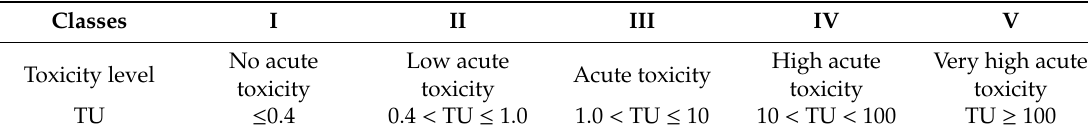
Table 5. Ecotoxicity classes defined according to the TCS system [41].